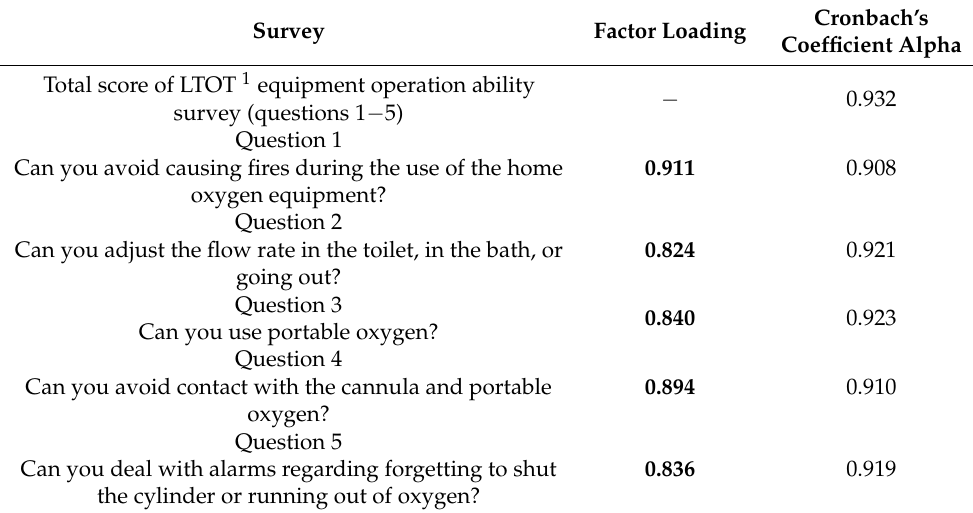
Table 4. Exploratory factor analysis and Cronbach’s coefficient alpha: survey regarding the ability to operate long-term oxygen therapy equipment ( n =